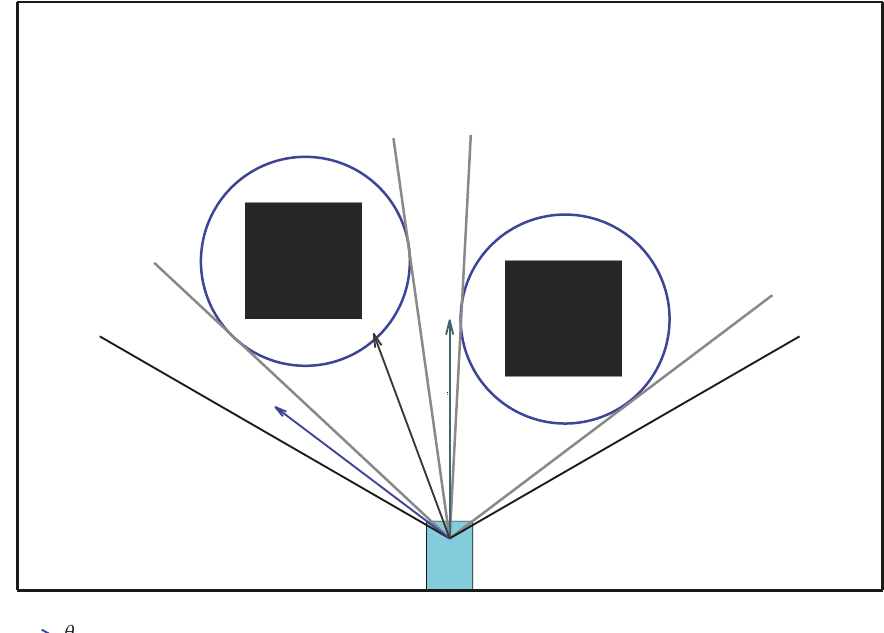
Figure 23: Guide angle calculation in